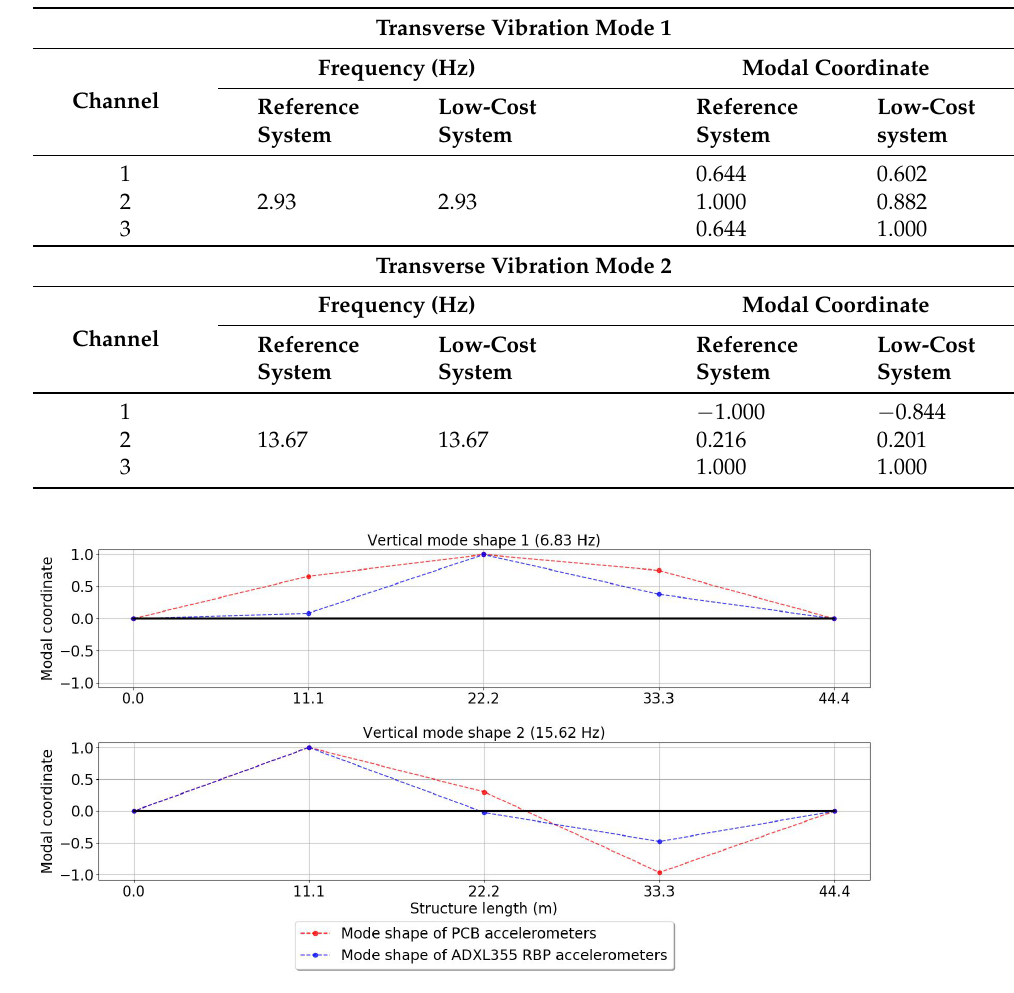
Figure 29. Vertical mode shapes of the railway bridge estimated by the monitoring systems.